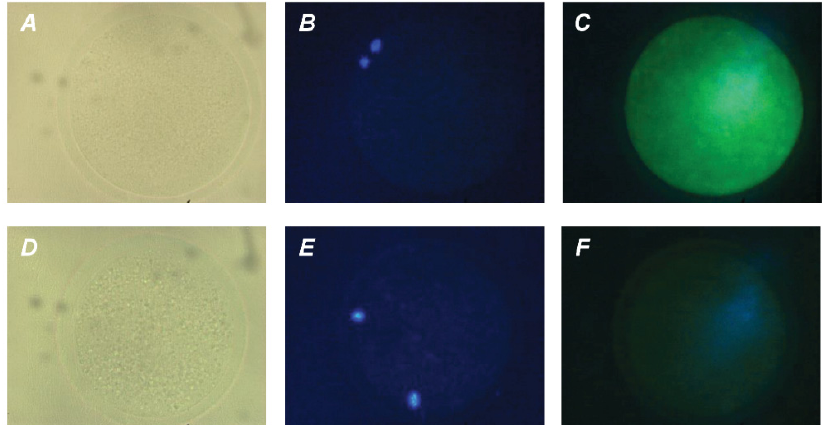
Figure 5. Immunofluorescent detection of GH receptors in M-II oocytes after the 20 h maturation of bovine CEOs. ( A , D ) Bright-field images. ( B , E ) DNA staining with DAPI (blue). ( C ) Positive staining using MAB 263 antibody and goat anti-mouse IgG conjugated with Alexa Fluor 488 (green). ( F ) Negative control performed by omitting the primary antibody. Original magnification: × 400.